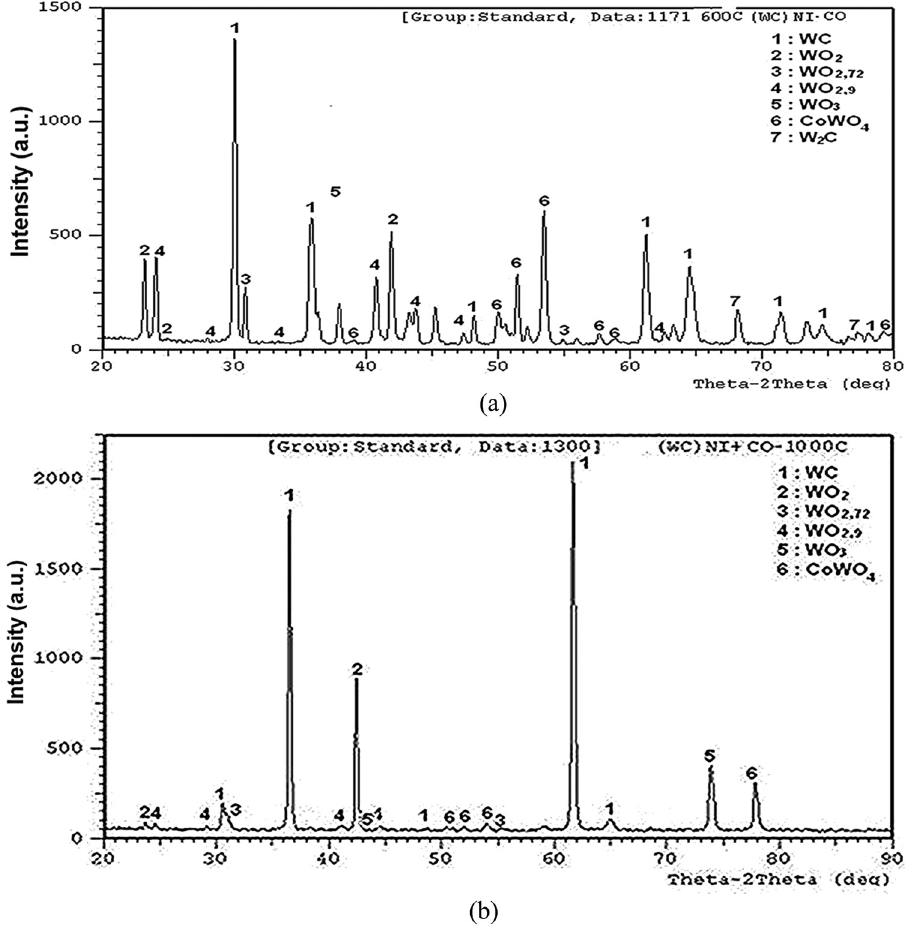
Figure 4: XRD analysis of ( Ni – Co – WC ) composite sintered in microwave furnace at ( a ) 600°C and ( b )